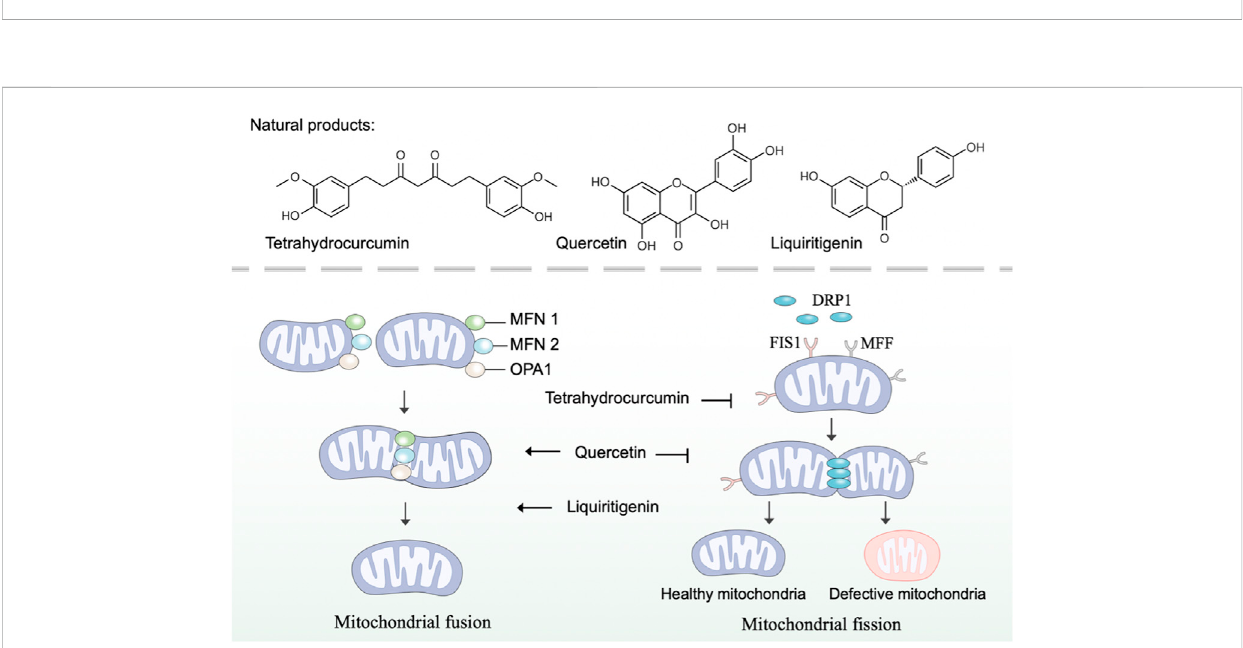
FIGURE 2 Natural products regulatemitochondrialfusion and fi ssion. Mitochondrialfusion ismediatedbyMFN1,MFN2,and OPA1, while mitochondrial fi ssion is mediated by DRP1, FIS1, and MFF. Natural products such as tetrahydrocurcumin, quercetin, and liquiritigenin regulate mitochondrial dynamics by modulating mitochondrial fusion and fi ssion